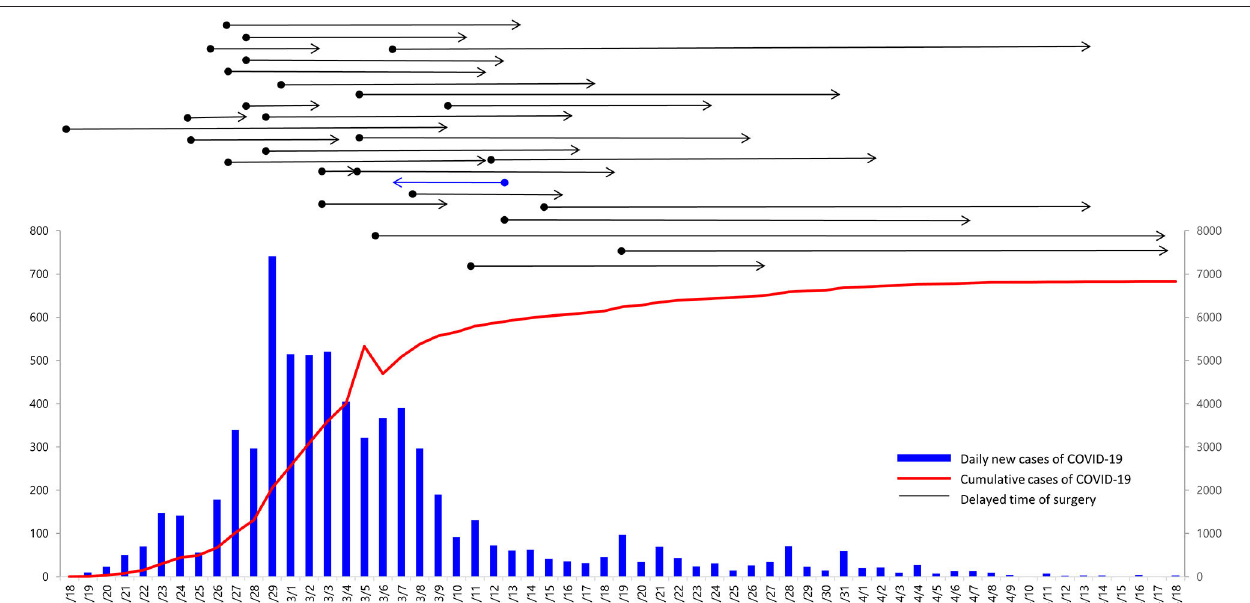
FIGURE 1 | Daily and cumulative number of COVID-19 cases in Daegu and delayed time of surgery for breast cancer during the COVID-19 outbreak. Overall, 27 patients wished to delay surgery to avoid COVID-19 infection in the hospital (black arrow lines). One patient who was excluded from this study wished to have an advanced operation day (blue arrow line).